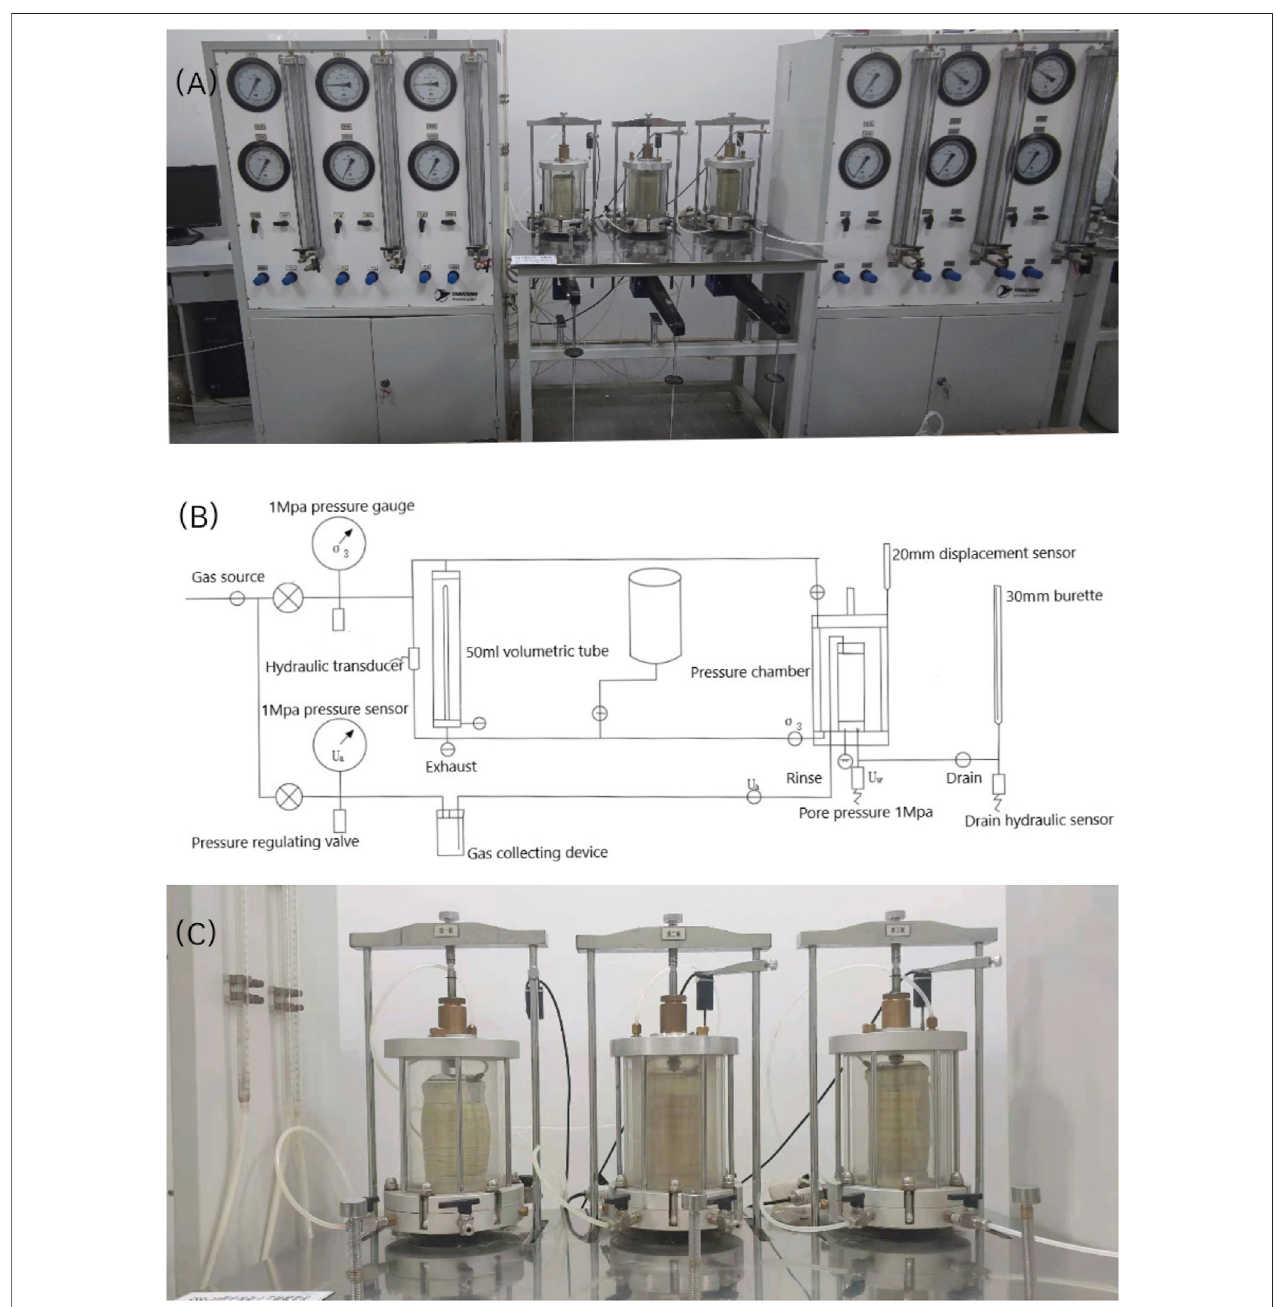
FIGURE 3 | (A) FSR-20 Unsaturated Soil Triaxial Creep Apparatus. (B) Schematic diagram of creep apparatus. (C) Creep